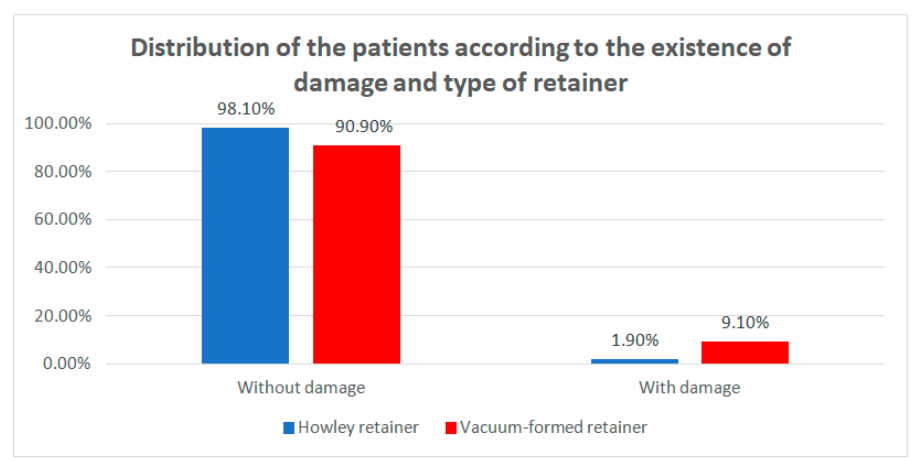
Figure 5. Distribution of the patients according to the existence of damage and type of retainer.